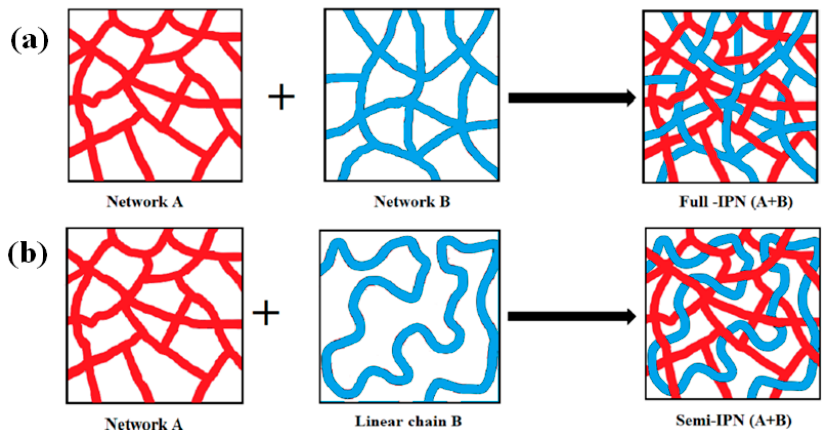
Figure 1. Schematics of the formation of ( a ) full interpenetrating polymer network (IPN) and ( b ) semi-IPN structures. Reprinted with permission from ref. [28], Copyright [2018], American Chemical Society.